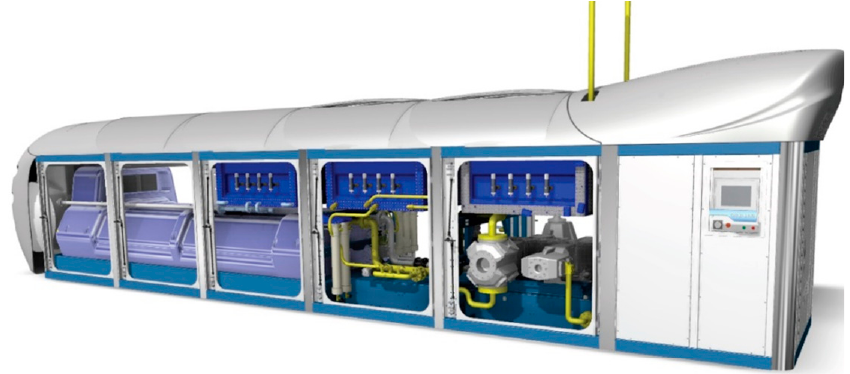
Figure 1. Illustration of a movable liquefied natural gas liquefaction plant.